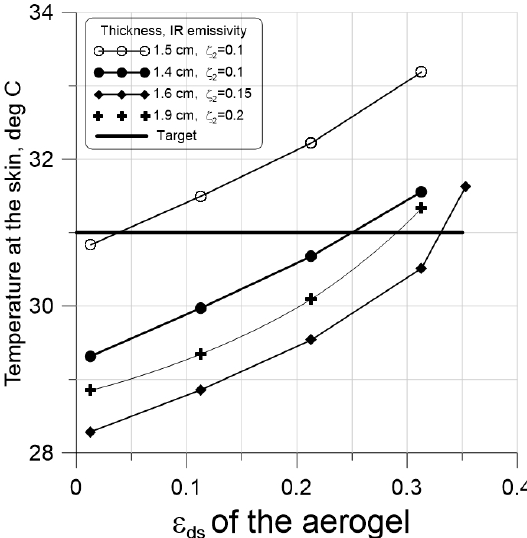
Figure 13. Influence of the volume fraction of aerogel ε ds on the skin temperature at different ζ 2 and insulation layer